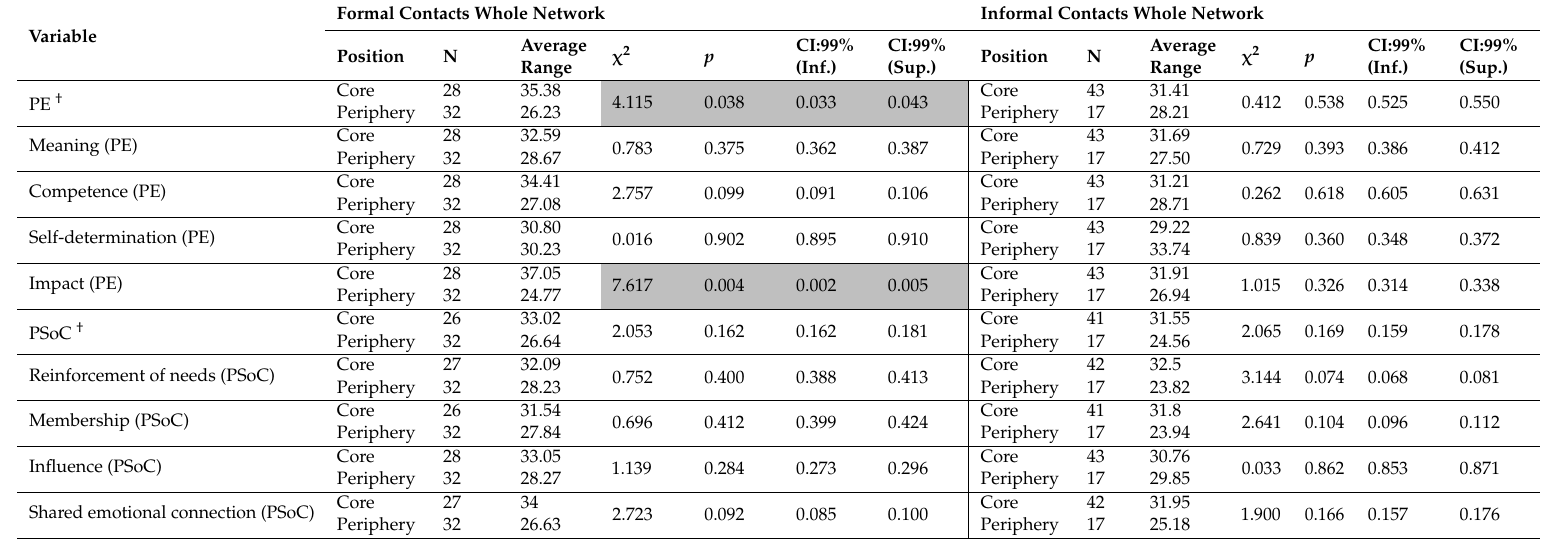
Table 3. Average range of PE and PSoC dimensions di ff erentiating between core and peripheral actors in formal and informal